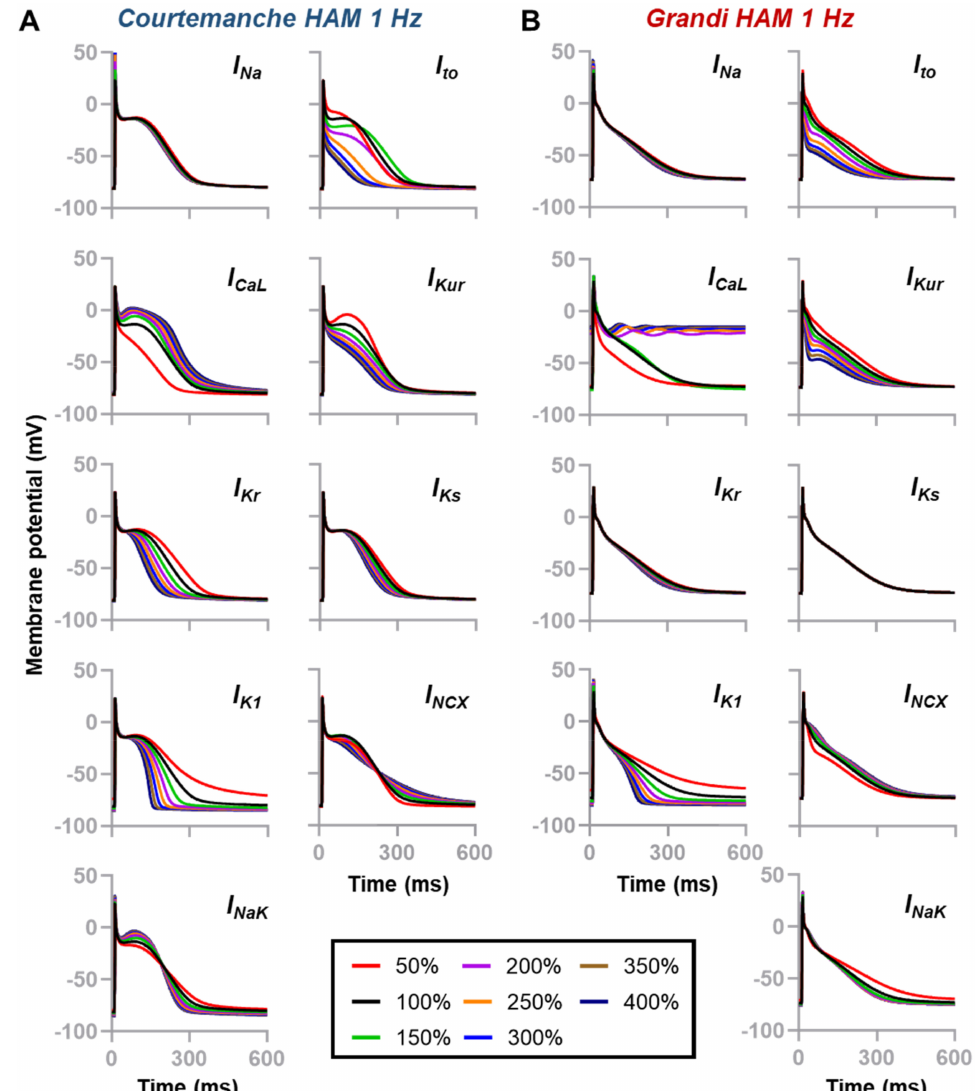
Figure 2. ( A , B ) Individual contribution of ionic currents on the repolarization of human atrial cardiomyocytes. Two human atrial cardiomyocyte models [Courtemanche et al. [6] and Grandi et al. [7]] were used to assess the contribution of nine major ionic currents (i.e., I Na , I to , I CaL , I Kur , I Kr , I Ks , I K1 , I NCX and I NaK ) on atrial repolarization. Channel maximum conductance (G max ) were scaled from 50% to 400% of the default